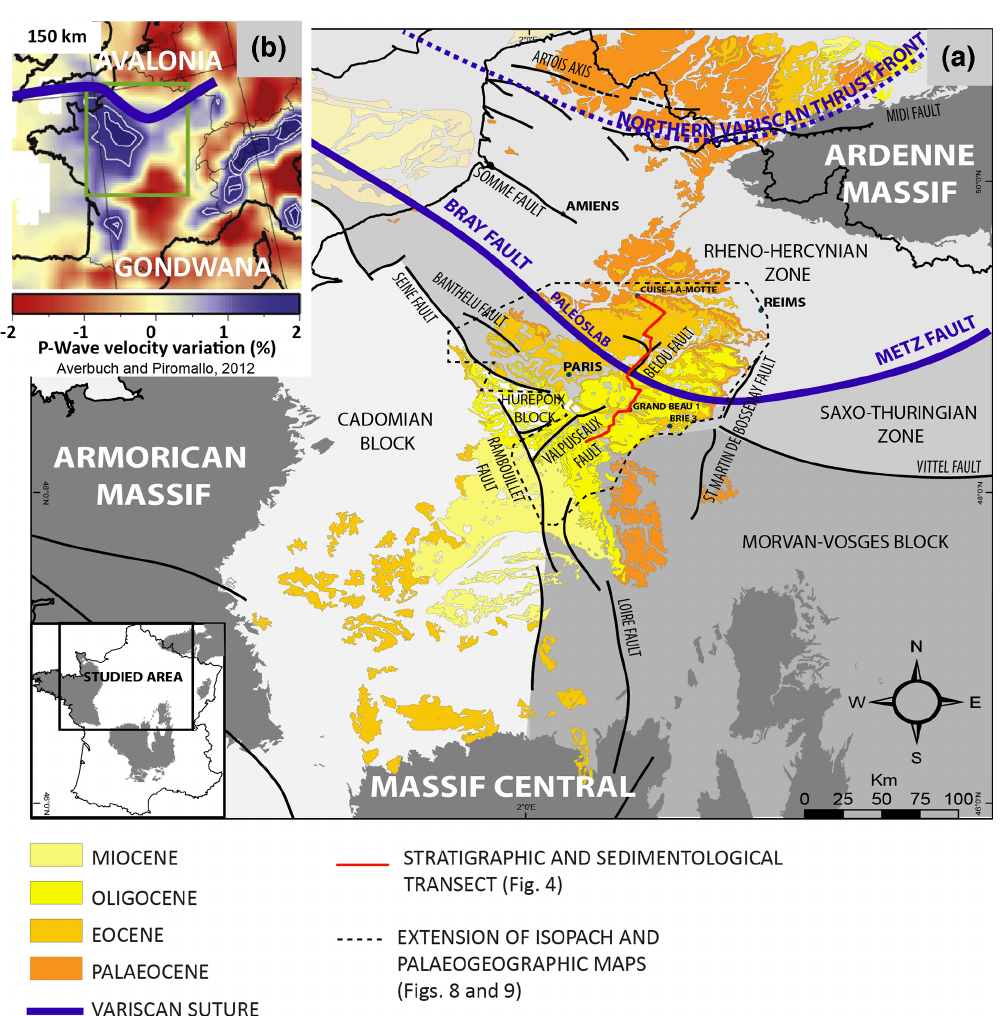
Figure 1. Geological characteristics of the Paris Basin. (a) Main tectonic units of the Variscan basement and present-day outcrops of the Cenozoic sediments. (b) P wave velocity at 150km below the Paris Basin, showing a major discontinuity below the Bray Fault (blue line), one of the sutures of the Variscan Belt (from Averbuch and Piromallo,